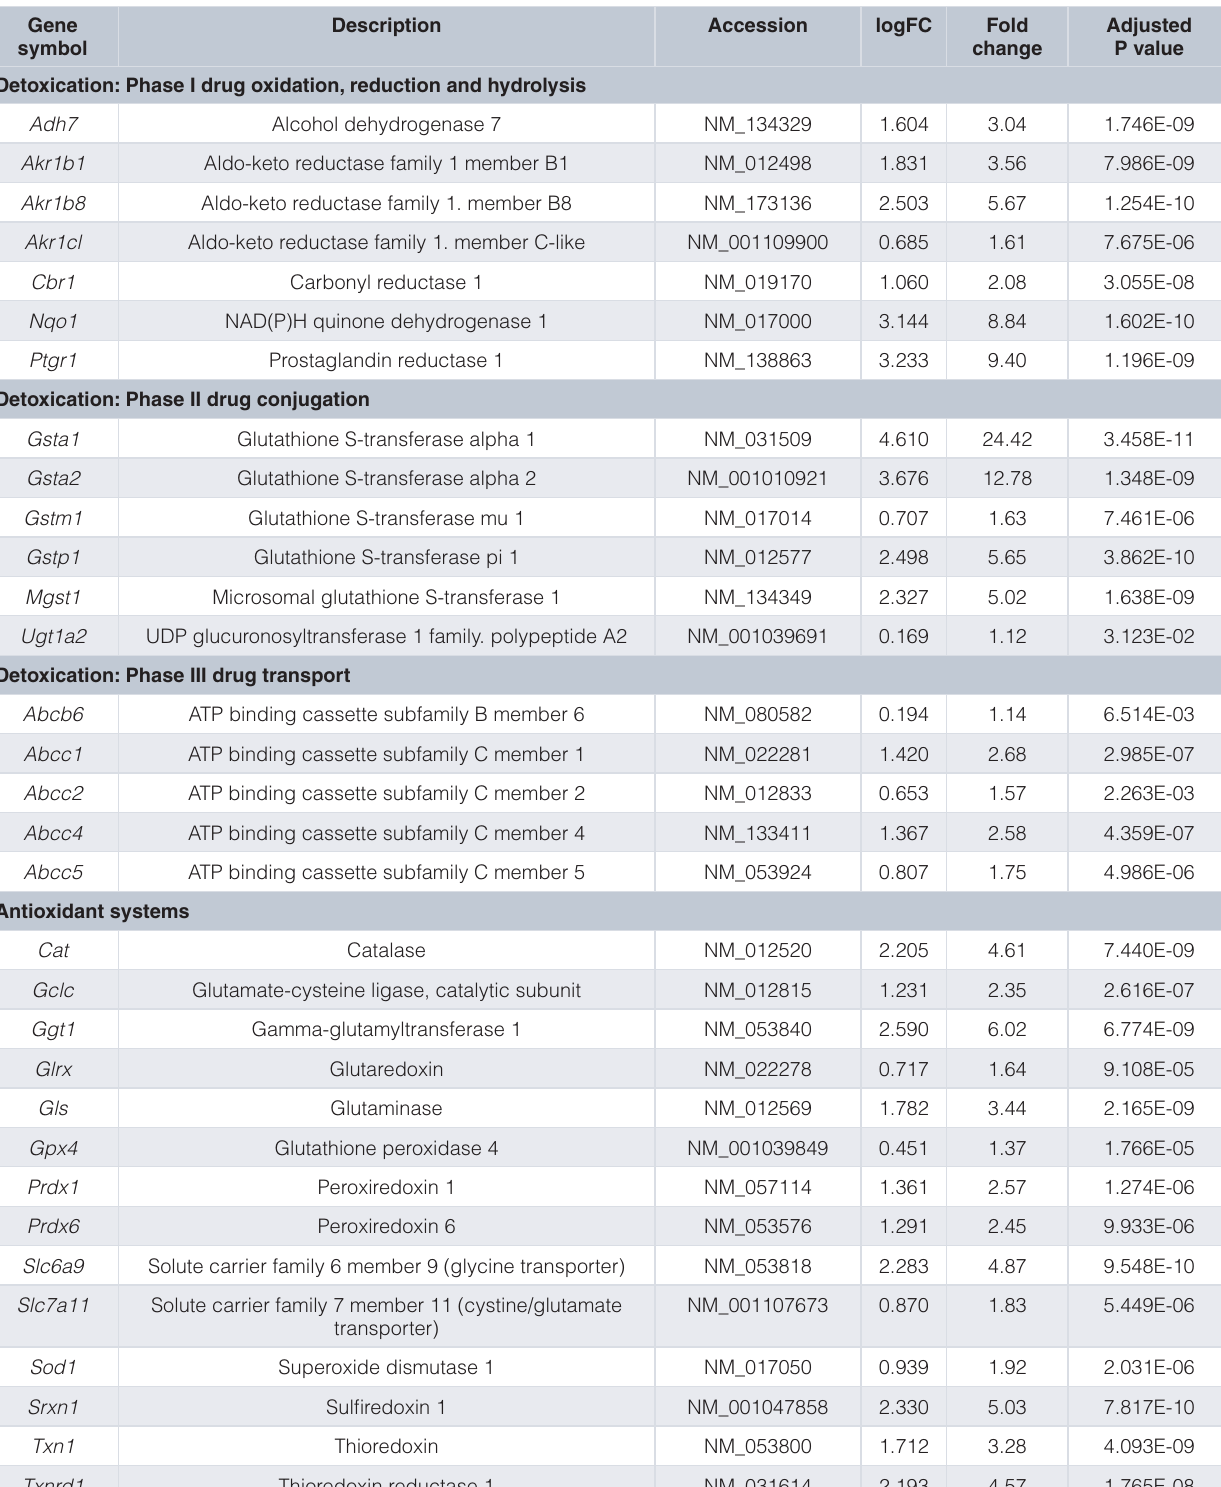
Table 1. Selected upregulated Nrf2 target genes in L6 myotubes after 24 h treatment with 60 µM GR24. Gene